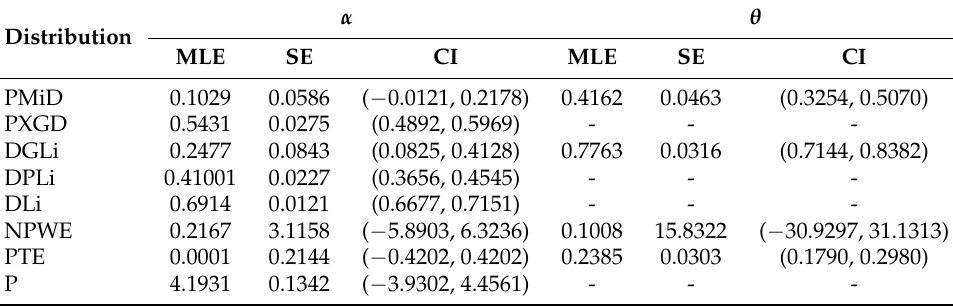
Table 5. Armenia dataset: MLEs of the parameters.